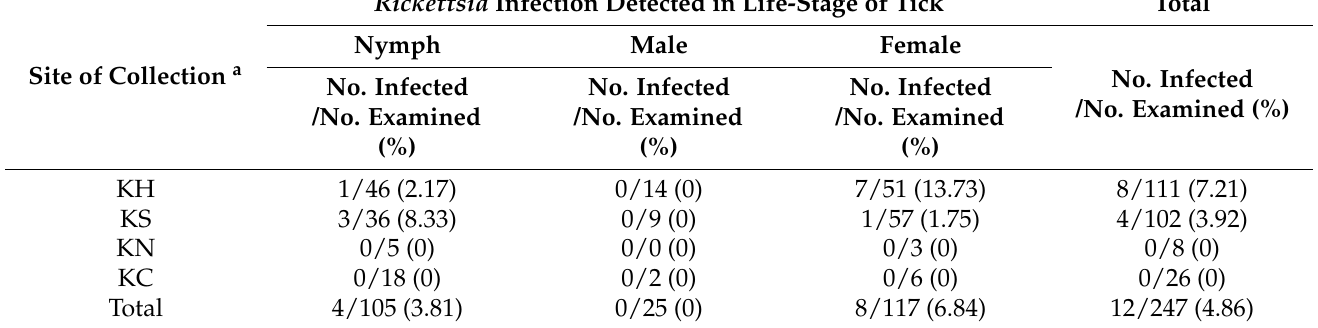
Table 2. Detection of Rickettsia infection in various life-cycle stages of Ixodes granulatus ticks collected from various sites of Kinmen Island, Taiwan by nested-PCR assay targeting the citrate synthase ( gltA ) gene of Rickettsia .